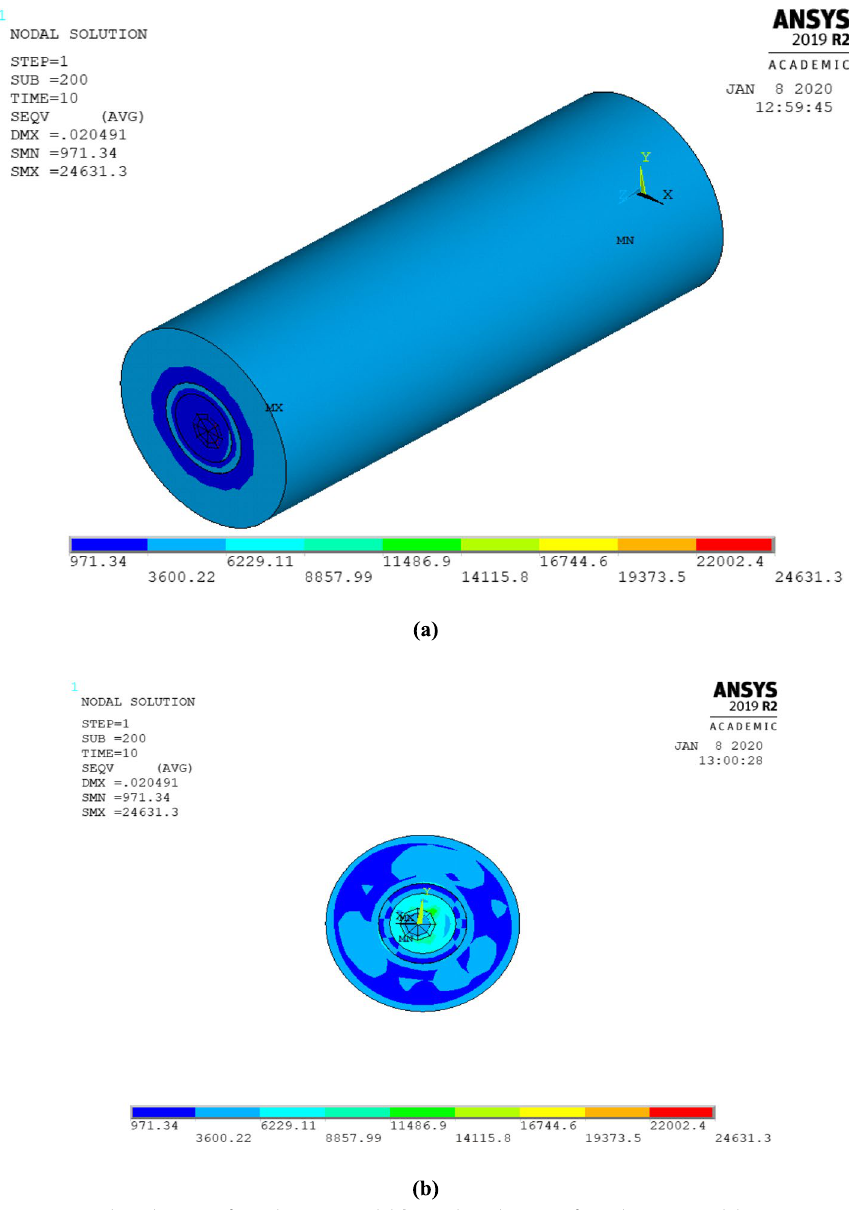
Fig. 15 a Combined stresses from dynamic model. b Combined stresses from dynamic